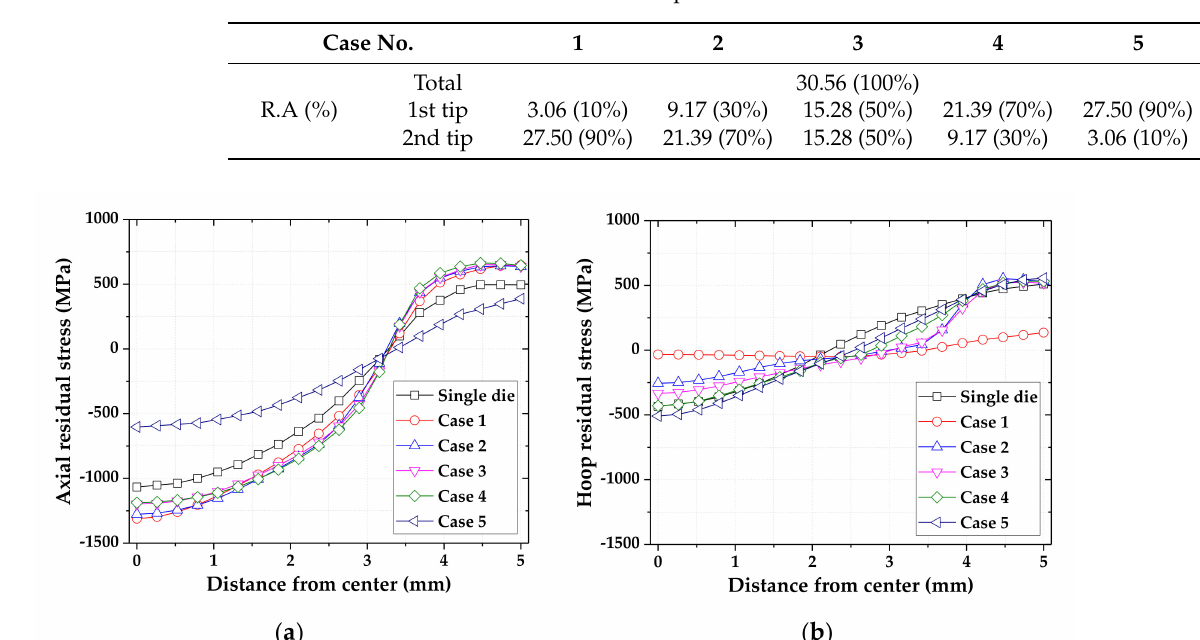
Figure 4. Residual stress of drawn material by double die tips according to the reduction in area (R.A): ( a ) axial residual stress; ( b ) hoop residual stress.